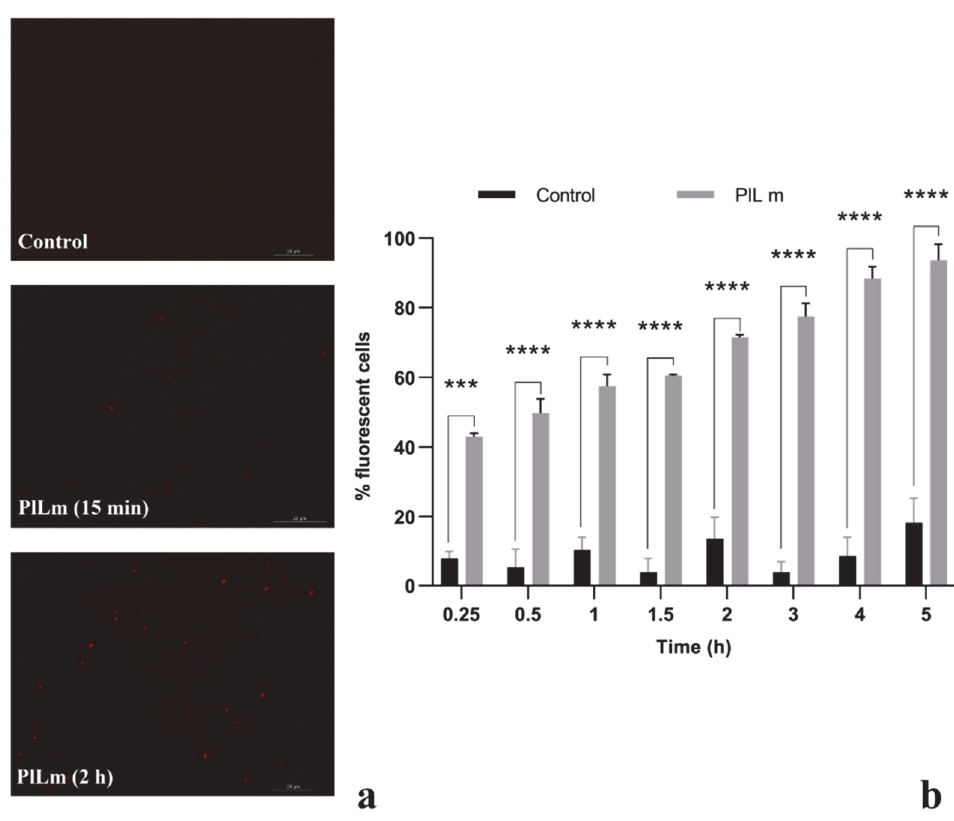
Figure 4. Effect of P. longifolia methanolic leaf extract exposure on S. aureus cell membrane integrity. Exponential-phase cells were treated with DMSO (control), PlLm extract (concentration equivalent to ½ MIC—samples), and stained with propidium iodide. Negligible levels of fluorescence were detected in the control after 3 h of incubation. Red fluorescent cells were detected in samples after 15 min and 2 h of incubation with PlLm, indicating membrane damage ( a ). The number of fluorescent cells significantly increased over time in the PlLm exposed samples ( b ). Values are the mean ± SEM. Bars indicate standard deviations. Asterisks denote a significant difference vs. Control (*** = p = 0.0001; **** = p < 0.0001).